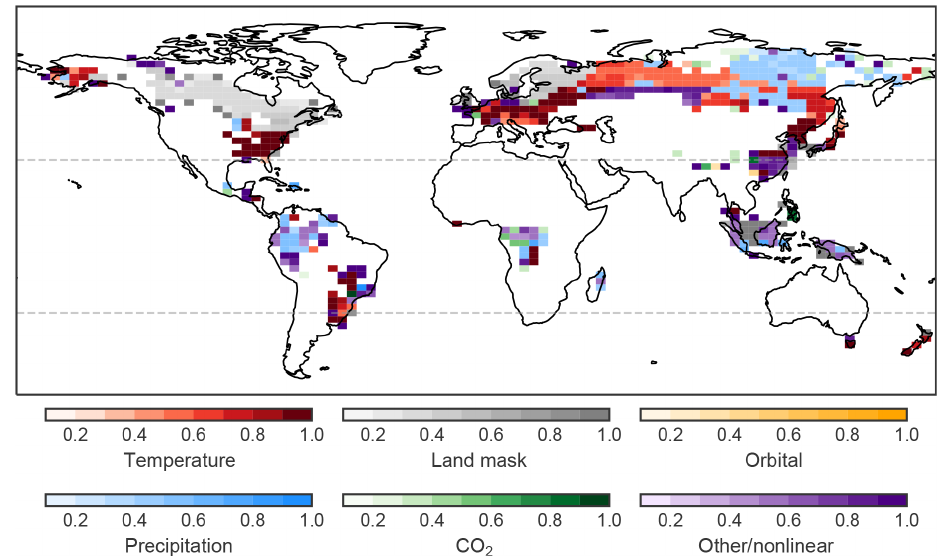
Figure 6. Drivers of the change in peatland area from LGM to present. Colors indicate the most important driver, and colored shading shows the contribution of the respective driver on a scale from 0 (no contribution) to 1 (only